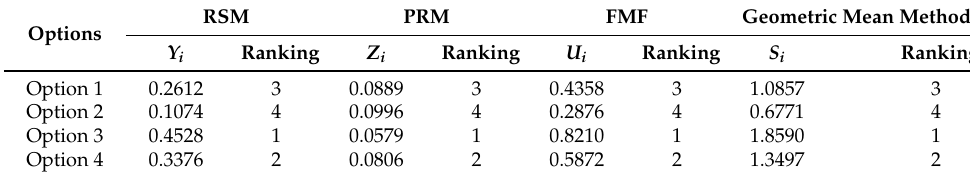
Table 6. The results from the weighted version of the MULTIMOORA